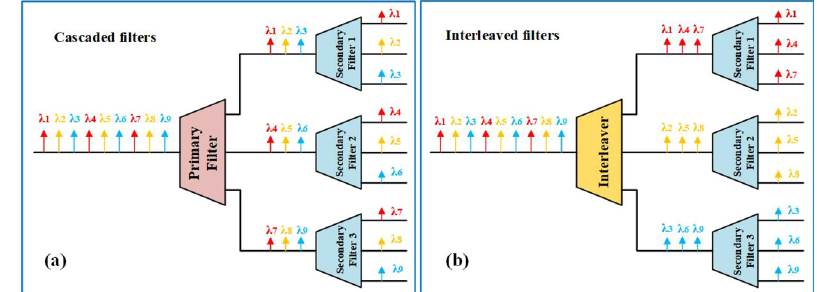
Figure 17: Schematic diagram of (a) cascaded fi lters and (b) interleaved fi